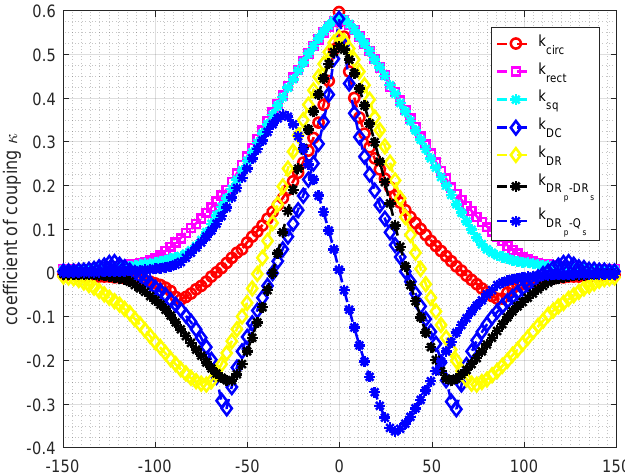
Figure 11. Coupling coefficients of single and multi-coil shapes with x-directional misalignment of coils in Table